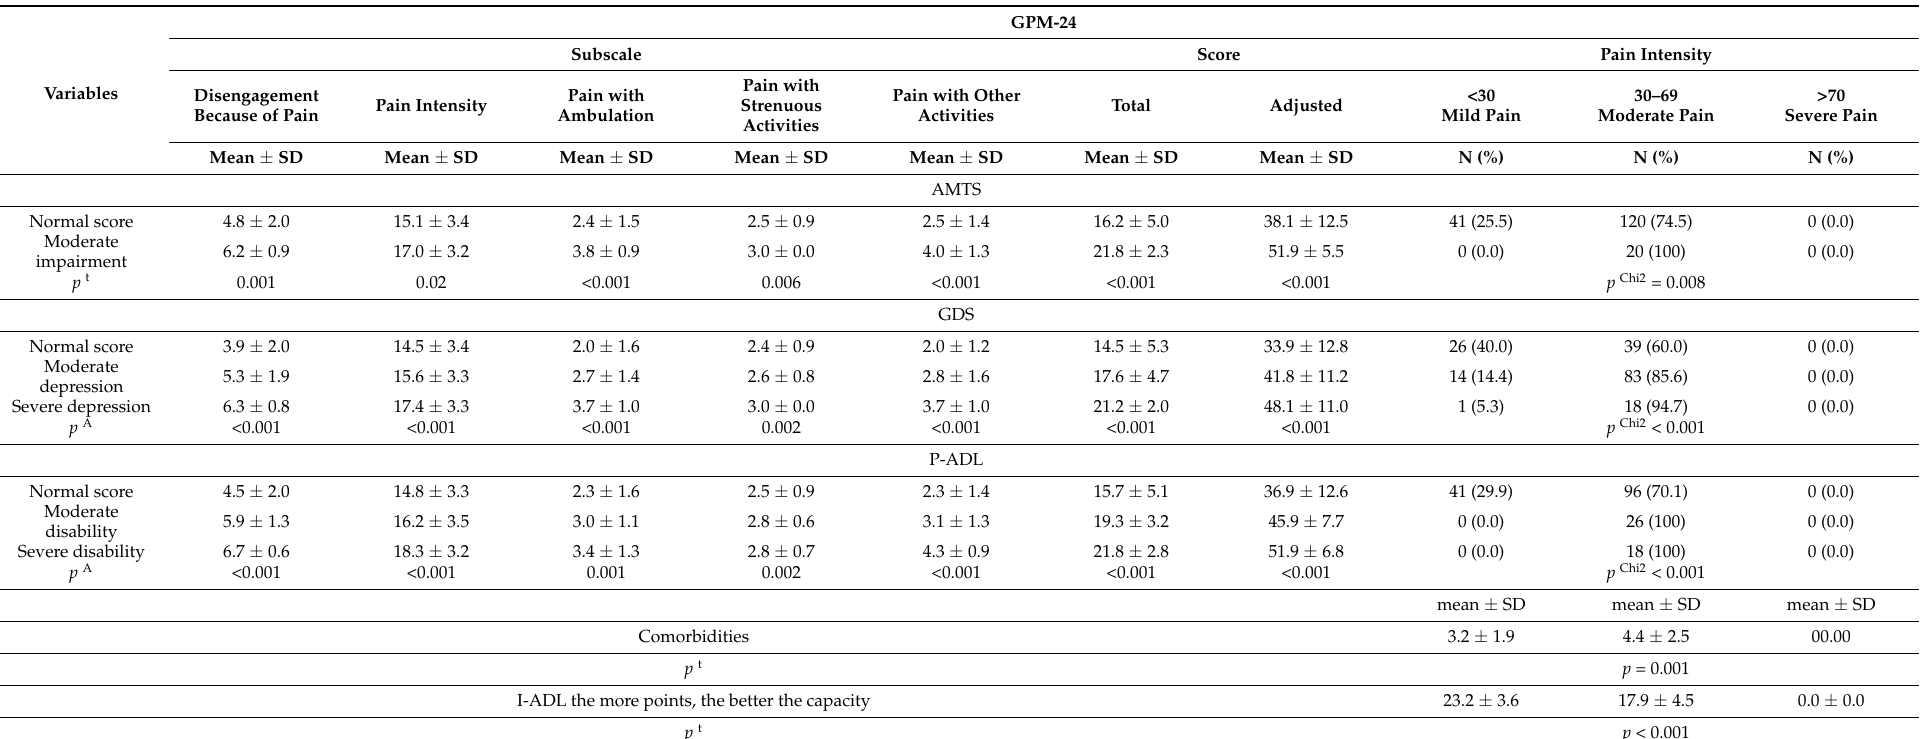
Table 3. Functional capacity variables correlate with pain measures in people with chronic